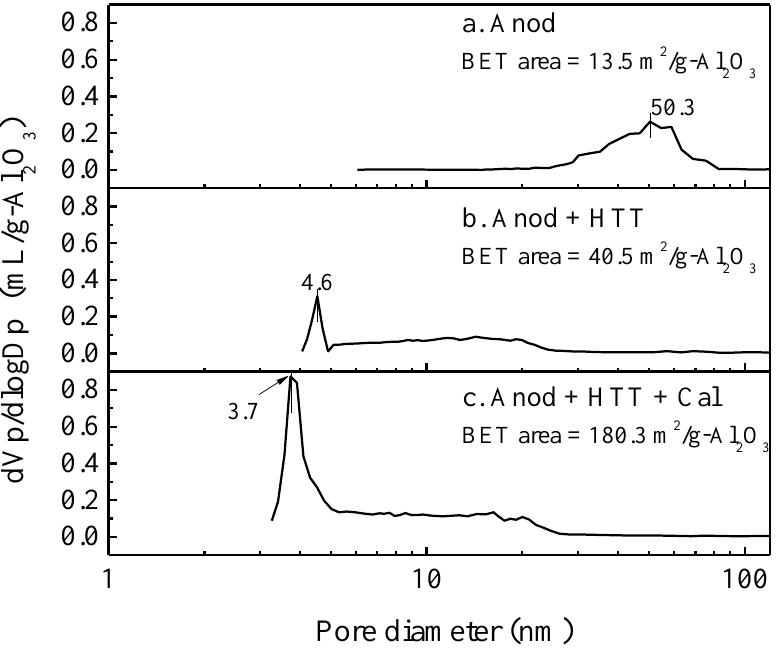
Figure 6. Pore-size distribution of PAA materials with different post-treatments.